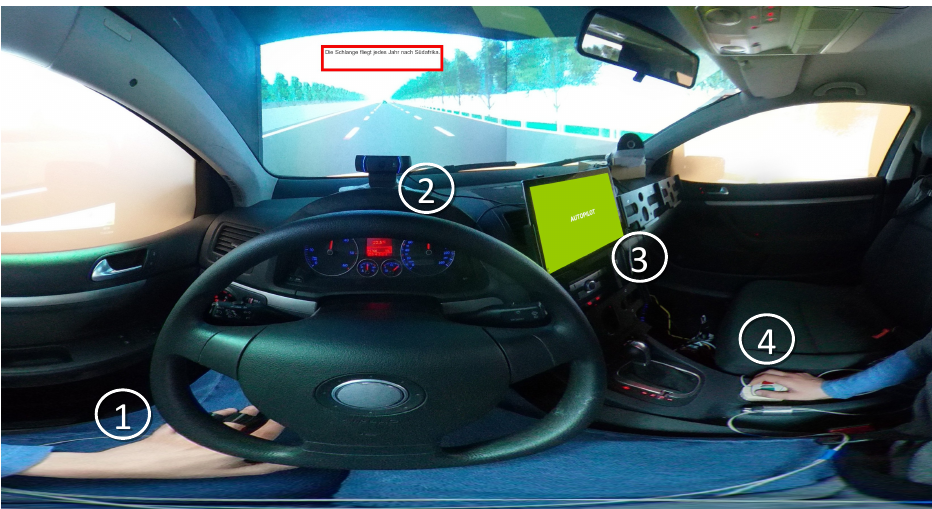
Figure 2. Driving Simulator Cockpit from participants’ perspective (wide-angle view), with (1) GSR electrodes attached to the left hand’s middle and ring finger, (2) observation camera, (3) driving mode display and (4) the computer mouse for task-responses. The HUD, which was only visible in the HUD condition, is highlighted with a red